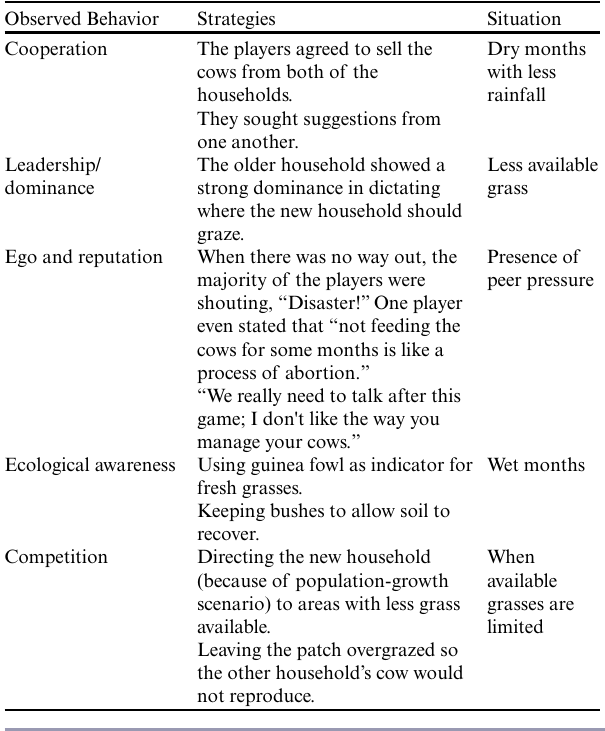
Table 4 . Observed coping strategies and behavioral responses to rainfall variability among grazing game players in